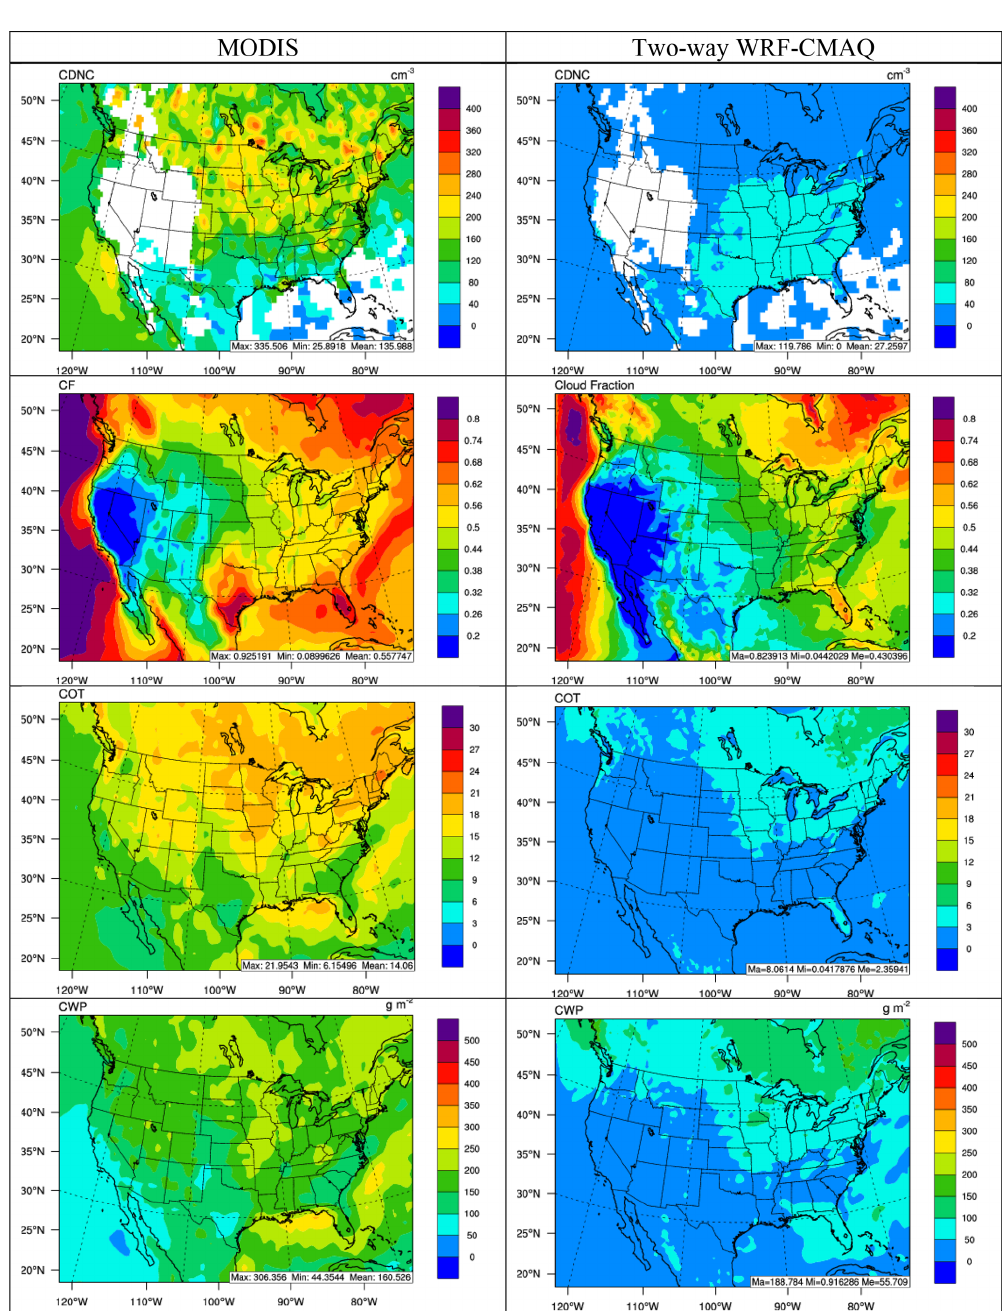
Figure 7. Spatial distribution of 5-year average major cloud variables (from top to bottom: CDNC, CF, COT, and CWP) between MODIS observations (left column) vs. two-way WRF-CMAQ (right column) in summer 2008–2012.